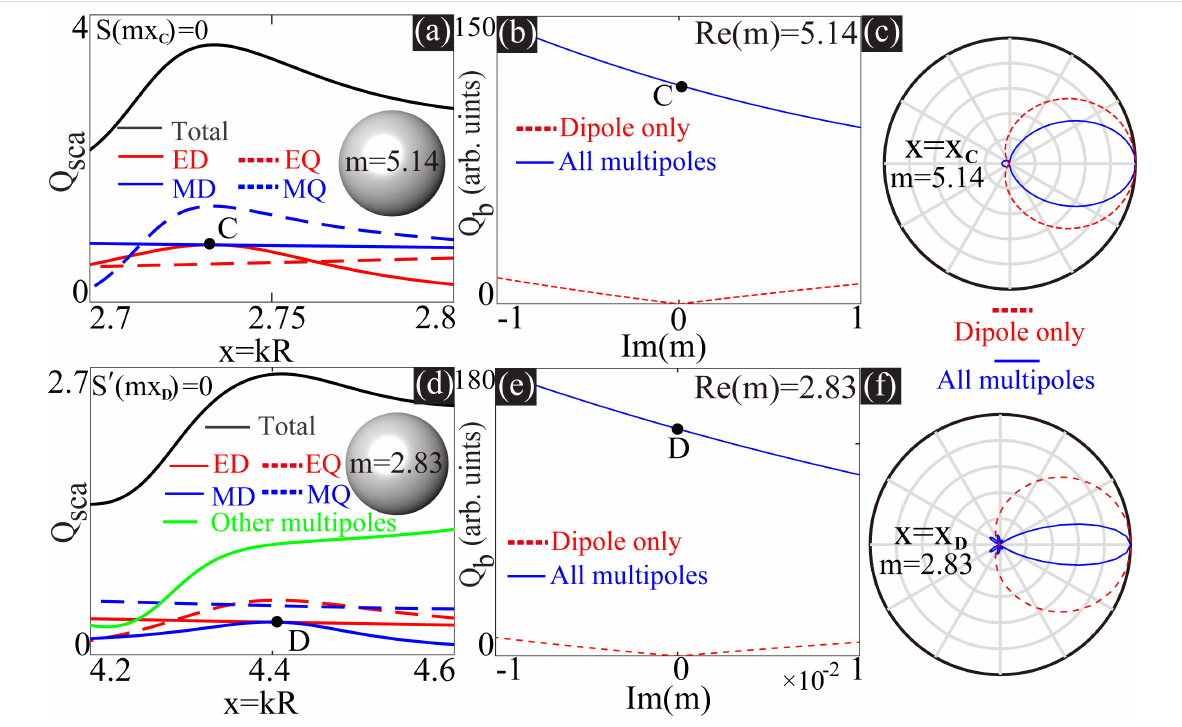
Figure 2: Scattering spectra are shown in (a) for m = 5.14 and in (d) for m = 2.83. For each scenario, there is an indicated point ( x C ≈ 2.7366 and x D ≈ 4.4123) where the dipoles are perfectly matched. (b, e) Dependence of Q b on Im( m ) at x C with fixed Re( m ) = 5.14 and at x D with fixed Re( m ) = 2.83, respectively. (c, f) The 2D angular scattering patterns (in the plane parallel to both polarization and incident directions) at x C with m = 5.14 and at x D with m = 2.83, respectively. In (b, c) and (e, f) two sets of results are shown, considering only dipoles or all multipoles, respective-